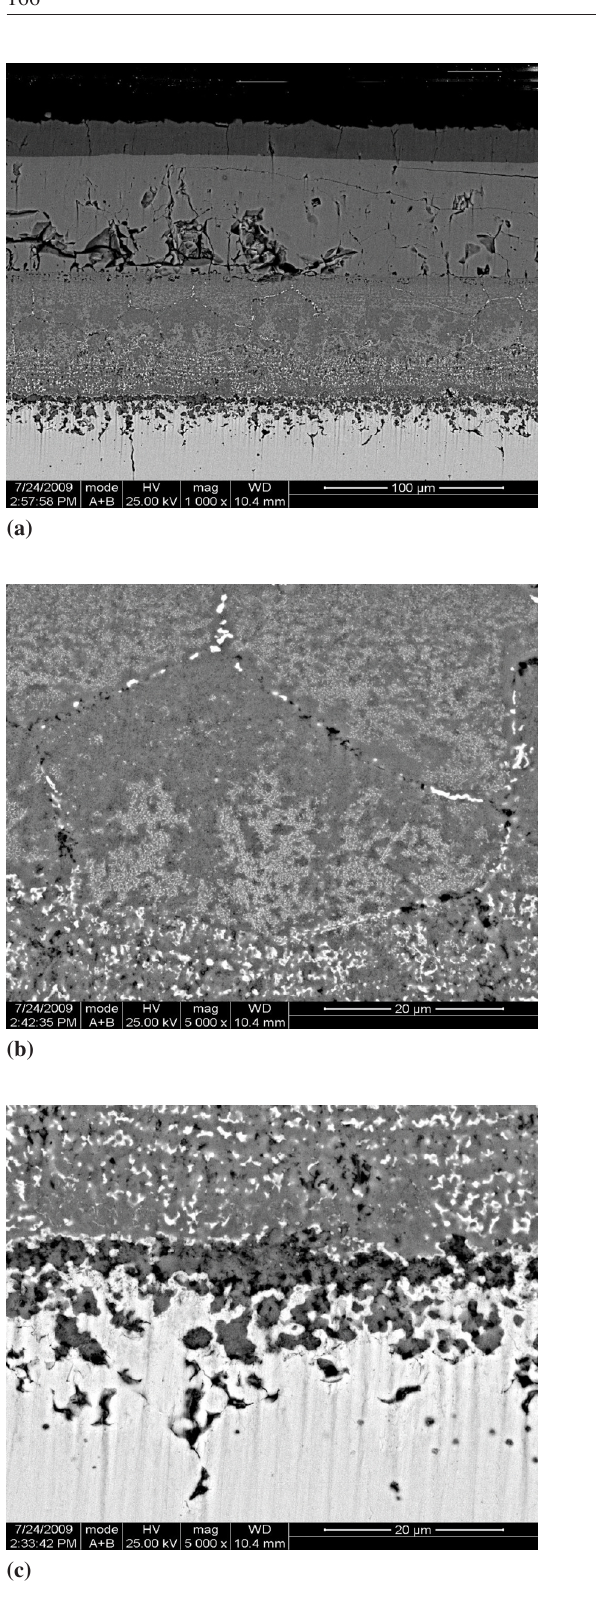
Figure 8. Cross-sectional morphologies of 316 SS corroded at 973 K in (Li,Na,K) 2 CO 3 -(Na,K)Cl for 500 h. (a) general view; (b) and (c) the amplified views of the inner layer of